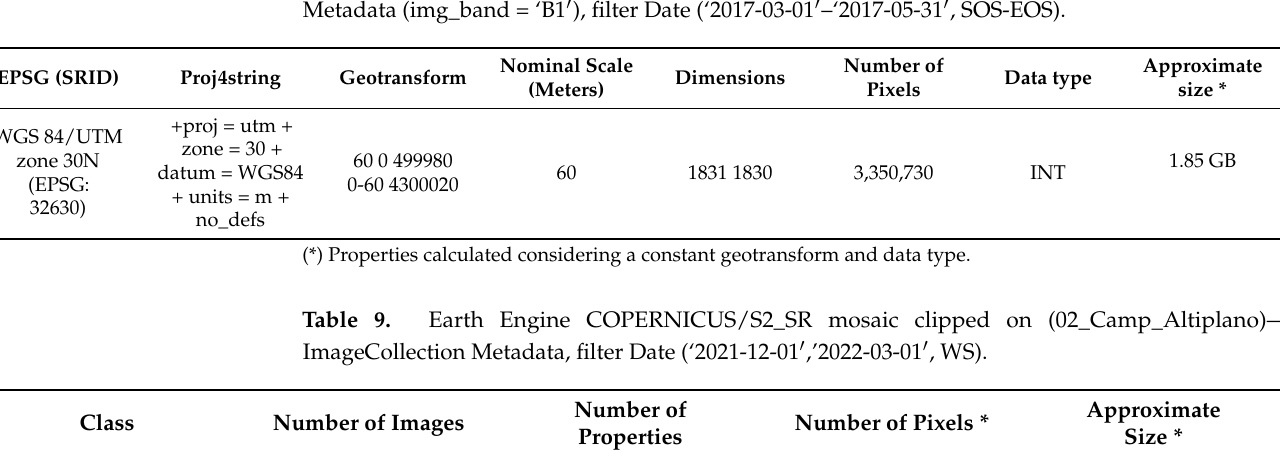
Table 8. Earth Engine COPERNICUS/S2_SR mosaic clipped on (01_Regenerative_Almonds)—Band